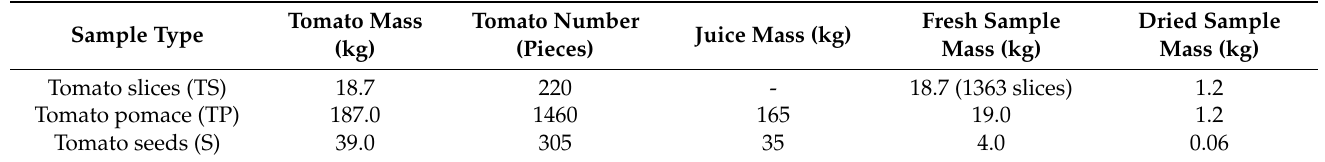
Table 2. Preparation of tomato samples: experimental data.